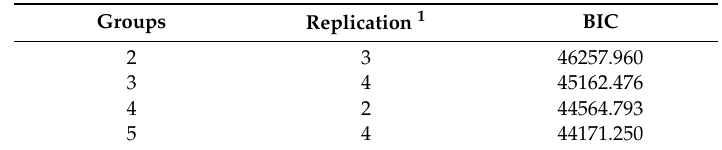
Table 2. Latent class clustering (lClass) analysis results: Comparison between the BIC (Bayesian information criterion) for cluster segmentation